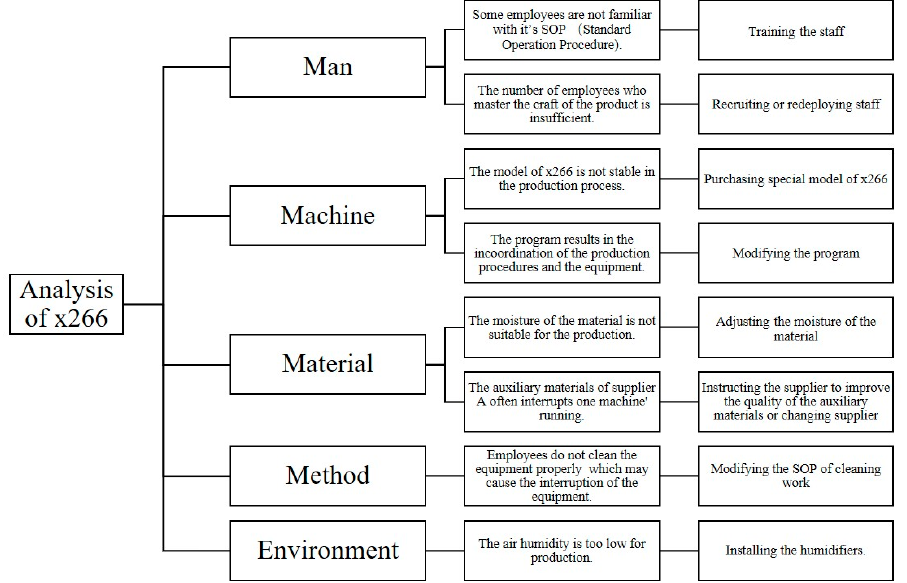
Figure 6. 4M1E analysis of 𝒙 𝟐𝟔𝟔 and improvement plans.